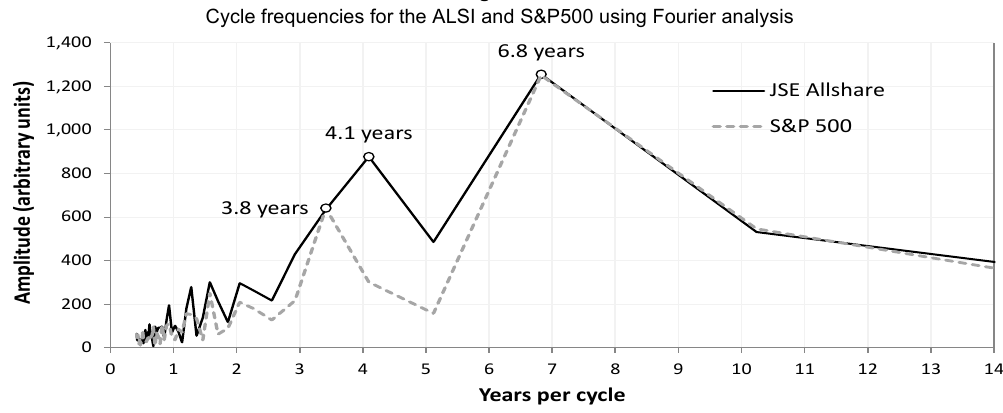
Cycle frequencies for the ALSI and S&P500 using Fourier